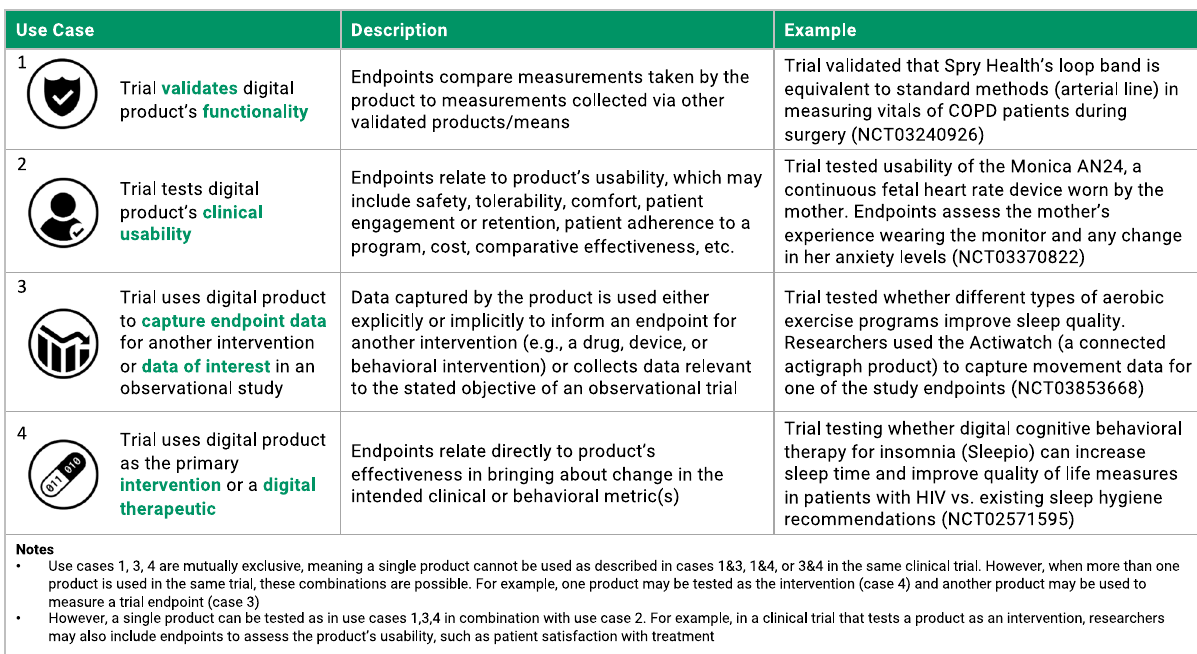
Fig. 4 Classifying connected digital product use in clinical trials. Connected digital products are used in clinical trials in four unique ways. Each method of use is described and an example trial from this study ’ s dataset is